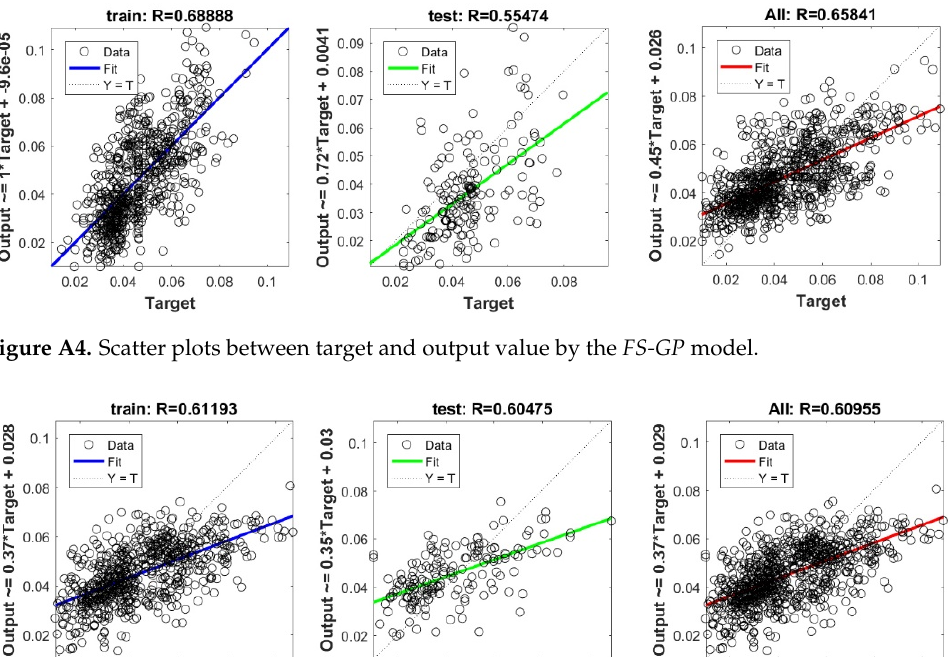
Figure A3. Scatter plots between target and output value by the FS-ELM model.